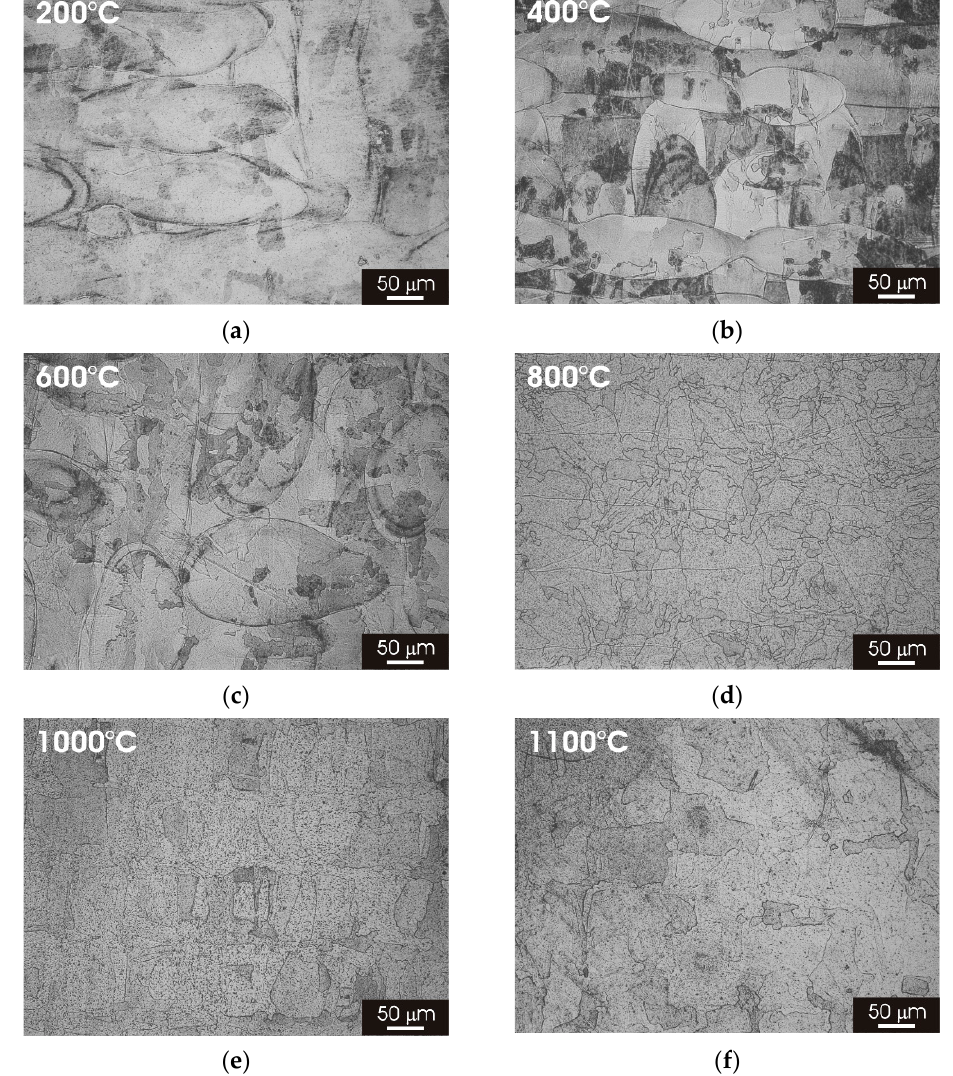
Figure 3. Optical micrographs of L-PBF-XY 316L stainless steel after 2 h thermal treatment. ( a ) 200 °C; ( b ) 400 °C; ( c ) 600 °C; ( d ) 800 °C; ( e ) 1000 °C; ( f ) 1100 °C.